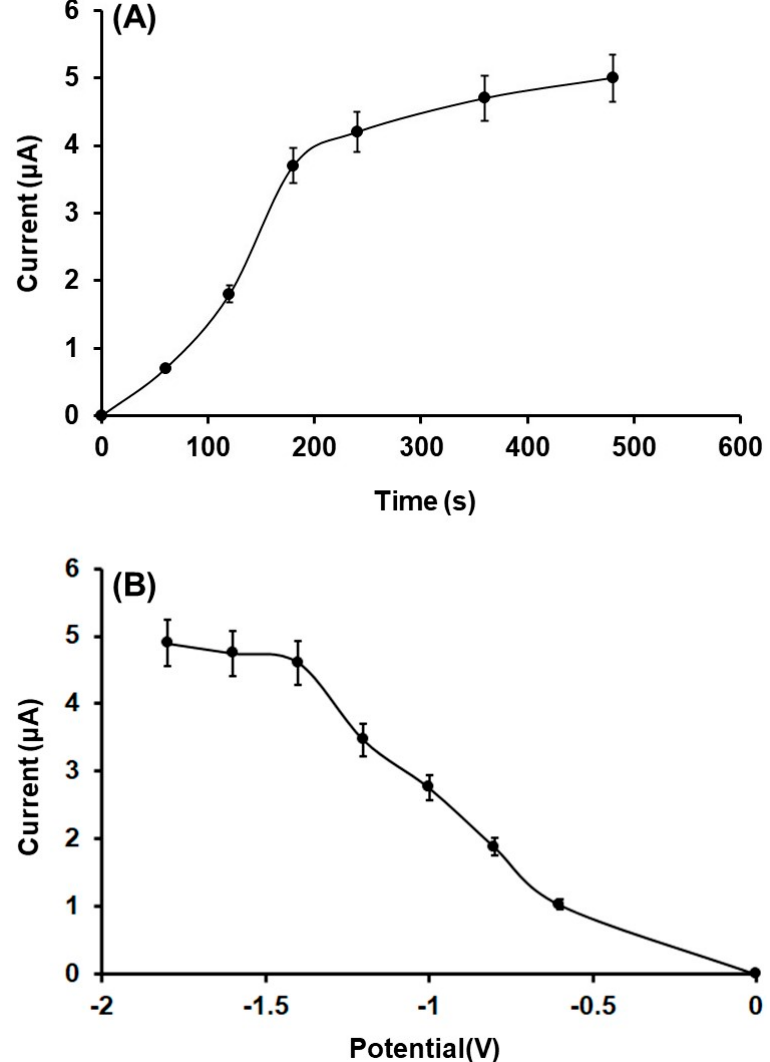
Figure 6. ( A ) Effect of the reduction time on the DPV peak current values of 250 µ mol L − 1 GLU in 0.1 mol L − 1 PB (pH 4) obtained with Fe 3 O(PhCO 2 ) 6 (H 2 O) 3 ] · PhCO 2 /3DPE applying a reduction potential at − 1.4 V. ( B ) Effect of the reduction potential on the DPV peak currents of 250 µ mol L − 1